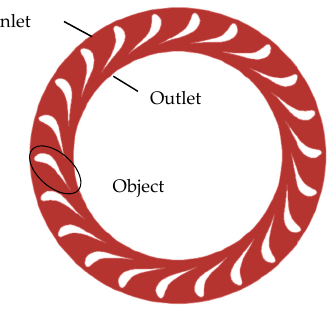
Figure 3. Two ‐ dimensional model of stator blade. Figure 3. Two-dimensional model of stator